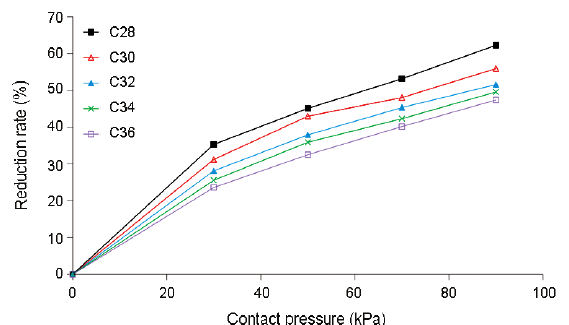
Fig. 13. Variation in oil film as a function of contact pressure for Hv